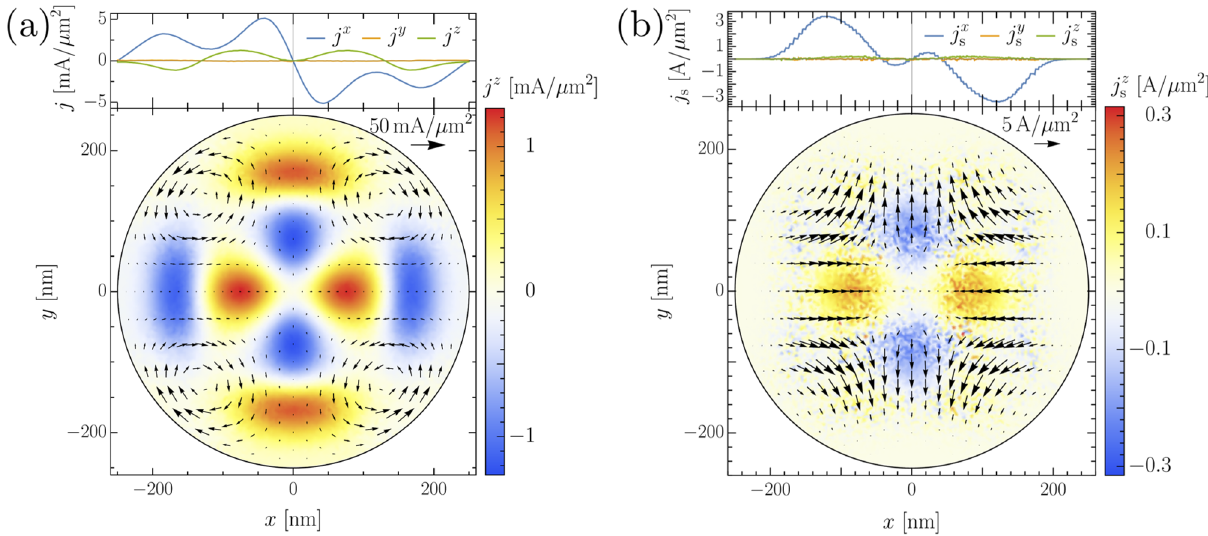
Figure 5. Spatial distribution in the xy plane and at z supercurrent ( b ) in the superconductor while the THz field fades away. Upper insets show the corresponding values along the x direction for y